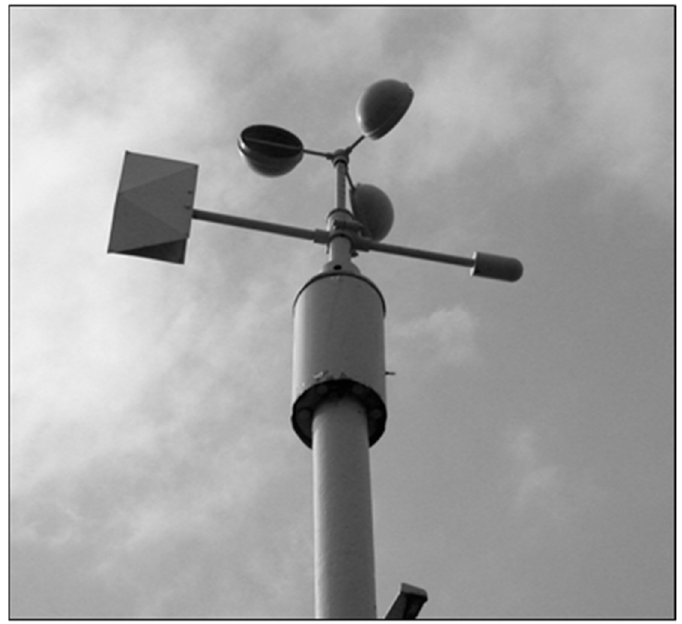
Figure 1. Cup anemometer mounted on a meteorological mast. Photo courtesy of Agencia Estatal de Meteorología (AEMET), Spain. http://hdl.handle.net/20.500.11765/11425 (accessed on 12 December 2022).